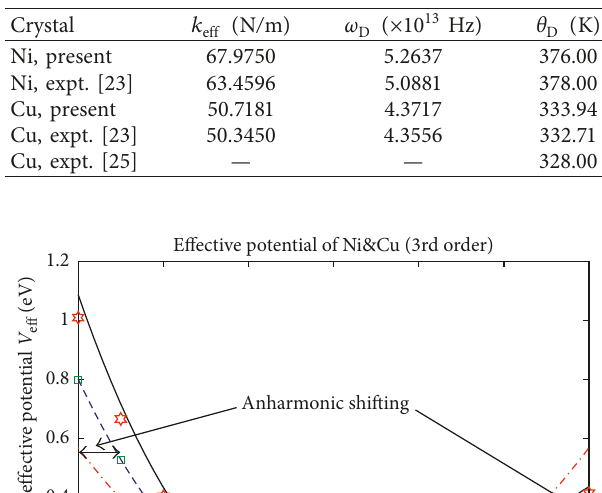
q of Cu and Ni calculated using ( )